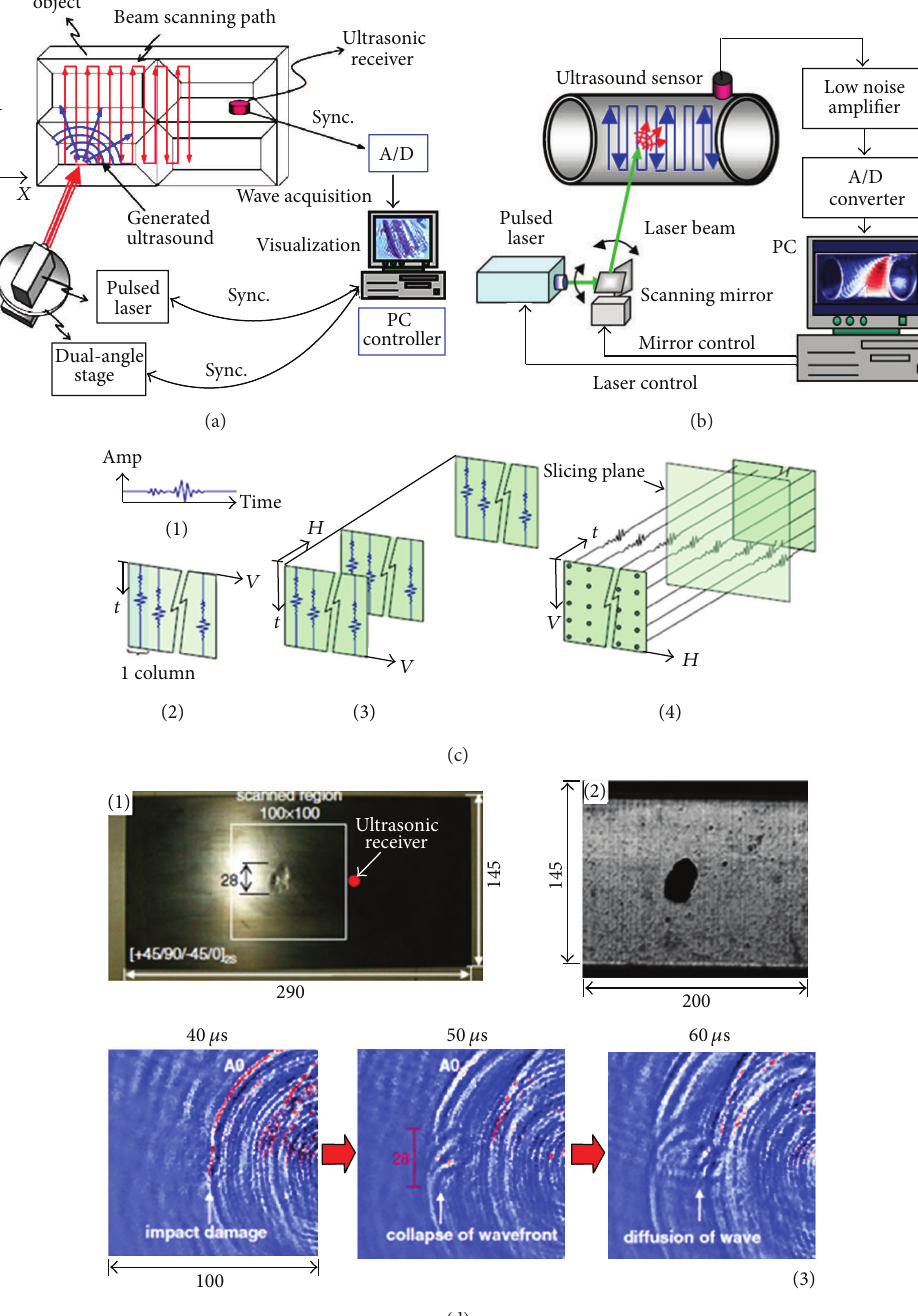
Figure30:Applicationofalaserforultrasonicwavegenerationandofapiezoelectricsensorforultrasonicwavedetection.(a)Laserultrasonic visualization system using a dual-angle stage for scanning; (b) laser ultrasonic visualization system using a scanning mirror; (c) illustration of an image construction process: (1) one ultrasonic signal saved, (2) matrix data structure for one vertical scan, (3) raw matrix data structure for the different vertical scans, and (4) data manipulated to fit the shown structure and sliced along the time axis; (d) application example for damage detection: (1) Hammer-struck damage on a CFRP skin, (2) C-scan image, and (3) wave field propagation snapshots in the vicinity of the impact damage (dimensions in